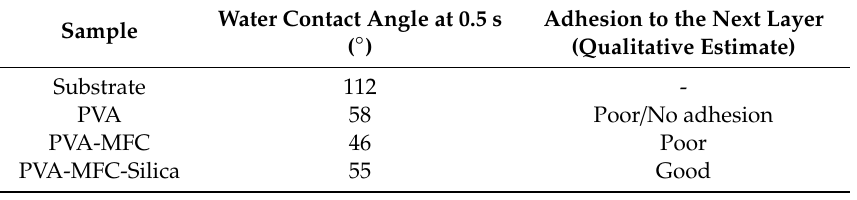
Table 3. Water contact angles of the coatings and adhesion performance.